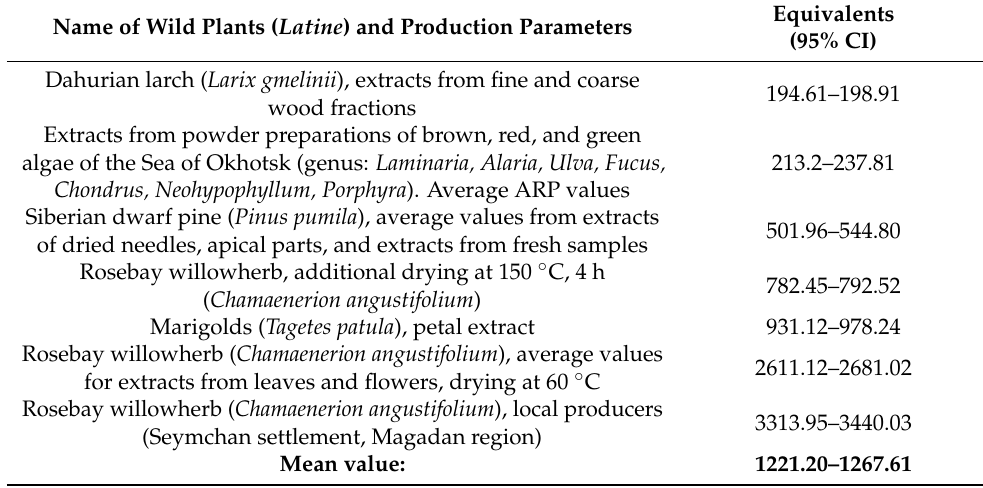
Equivalents (95% CI) 194.61–198.91 213.2–237.81